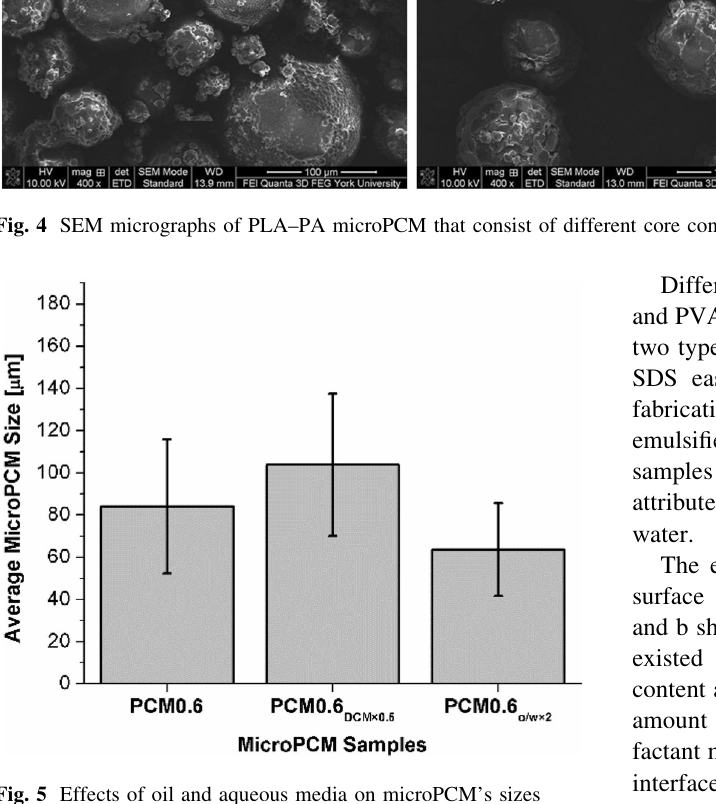
Fig. 5 Effects of oil and aqueous media on microPCM’s sizes